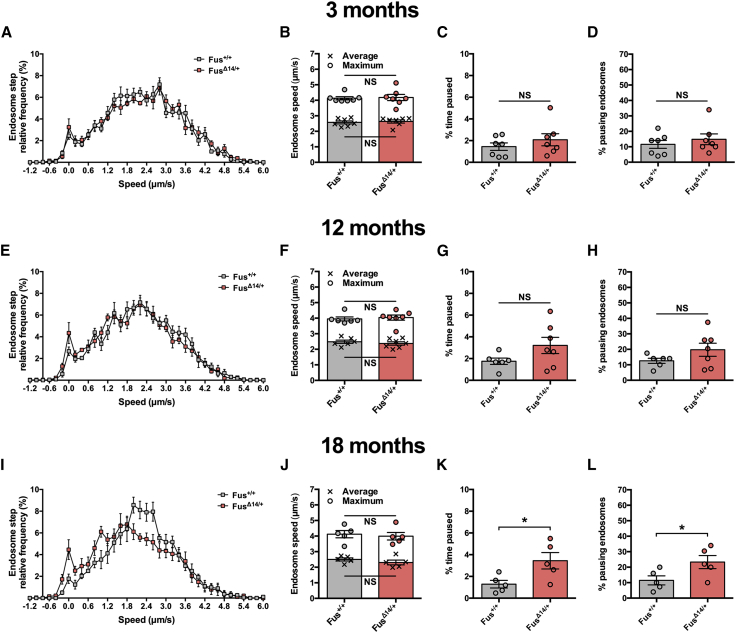
FusΔ14/+ Mice Display a Minor Impairment in Axonal Transport of Endosomes, but Only at a Late Disease Stage(A–H) The axonal dynamics of signaling endosomes are similar between Fus+/+ (gray) and FusΔ14/+ (red) mice at 3 months (A–D) and 12 months (E–H) of age.(I–L) At 18 months, retrograde axonal transport speed of endosomes is unaffected in FusΔ14/+ mice (I and J); however, mutant Fus mice do show a significant increase in the percentage of time that endosomes pause for (K) and the percentage of endosomes that paused (L).∗p < 0.05; NS, not significant, unpaired t test. n = 5–7. Means ± SEM are plotted for all graphs.See also Figures S3 and S4.